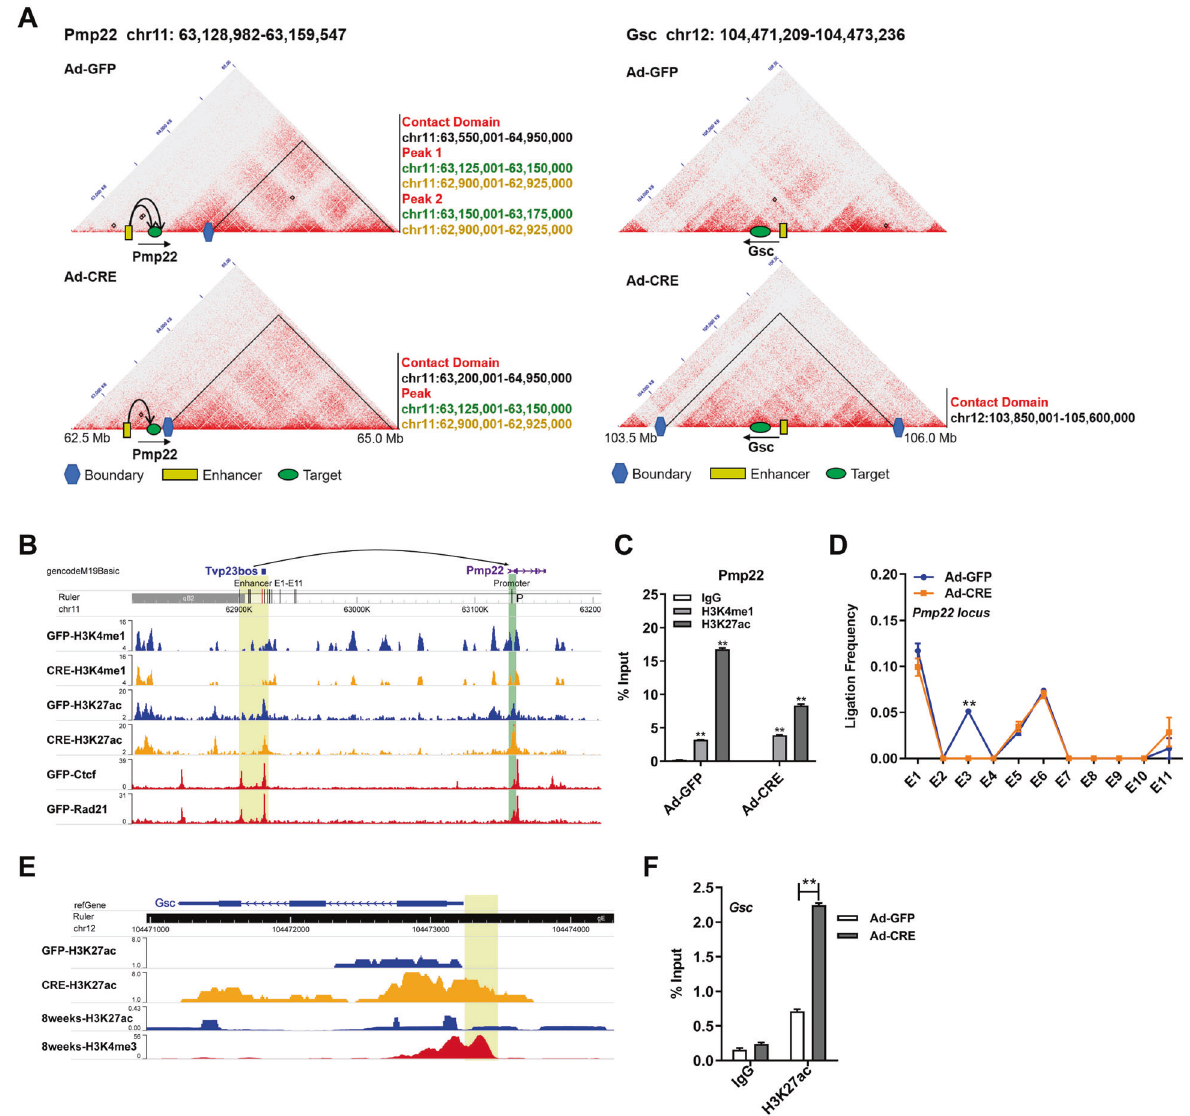
high frequency of interactions, and the position information are labelled in black font. Locally enriched peaks discovered via HiCCUPS are referred to as chromatin loops, and location coordinates are shown in green (the target gene) and yellow (the potential enhancers) font in line with the colors of graphic symbols. B Expanded views of the potential enhancer locus and proximal promoter of Pmp22 , with H3K4me1 and H3K27ac ChIP-seq tracks for recognition on the potential enhancers, and Ctcf and Rad21 ChIP-seq tracks for pointing the anchored loops in AB17 cells. Vertical black bars label the enhancers and promoter primers examined in the 3C assay. C Identi fi cation on enhancers of E-P loops in Pmp22 . The position of primer for the enhancer is labelled by the vertical red bar. Histone marks H3K27ac and H3K4me1 were signi fi cantly enriched at enhancer locus of Pmp22 in AB17 with IgG as control. D Curve graphs indicate the signi fi cantly reduced ligation frequencies at E-P anchored loops of Pmp22 in Arid1a -de fi cient cells. E Validation on a regulatory pattern of the up-regulated gene Gsc within switched A compartment. H3K27ac and H3K4me3 ChIP-seq tracks were obtained from AB17 cells and ENCODE database (H3K27ac: ENCSR000CDH; H3K4me3: ENCSR000CAP), and the location of enhancer boxed with the yellow rectangle. F A signi fi cantly increased the H3K27ac signal of the Gsc gene detected in Arid1a knockout cells with IgG as